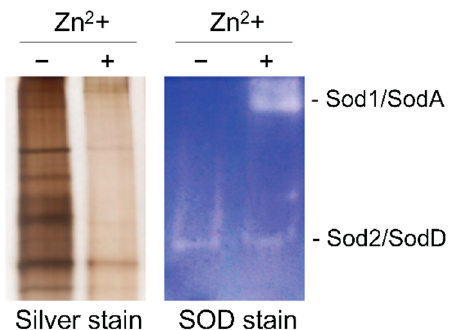
Figure 9. Detection of superoxide activity onto PAGE gels. Total extracts of native proteins were obtained from a wild-type strain of A. fumigatus grown under zinc-limiting (SDN–Zn) and zinc-replete conditions (SDN + 100 µM Zn), separated in a PAGE gel (T = 8%) and stained as described in the materials and methods section. Sod1/SodA is a cytosolic Cu/Zn-dependent superoxide dismutase whereas Sod2/SodD is a mitochondrial Mn-dependent superoxide dismutase.